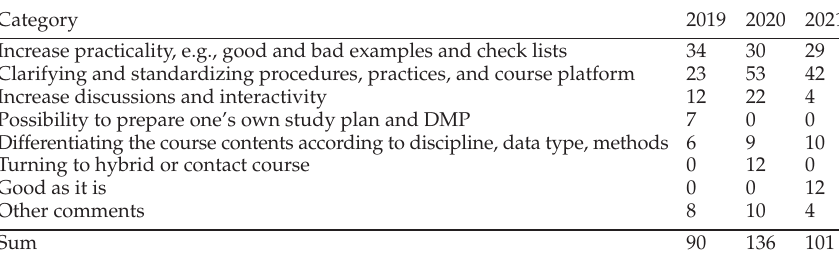
Table 5: How would you suggest the module be developed? Category Increase practicality, e.g., good and bad examples and check lists